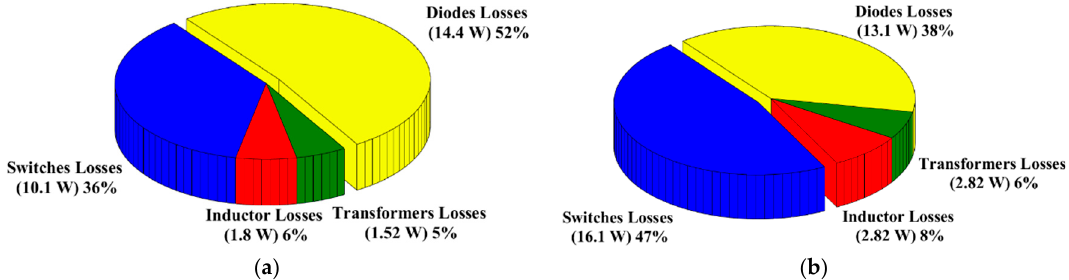
Figure 8. Loss breakdown ( a ) half-load condition (P o = 500 W); and ( b ) full-load condition (P o = 1000 W).